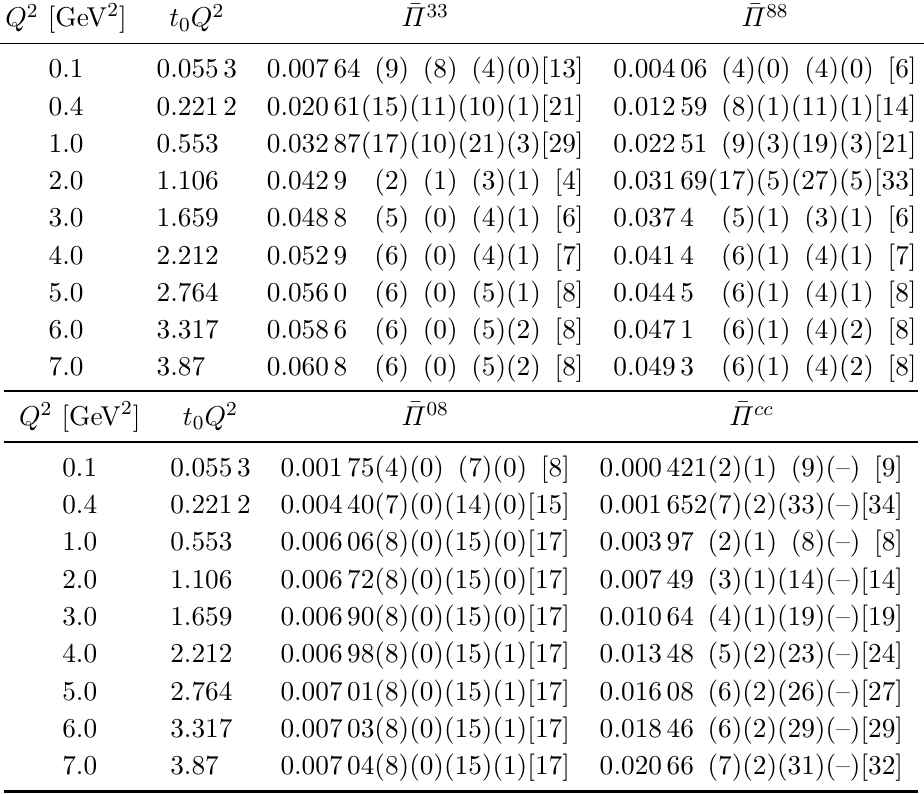
Table 5 . Contributions to the running extrapolated to the physical point. The first quoted uncertainty is the statistical error, the second is the systematic error from varying the fit model estimated in section 4.1.1, the third is the scale-setting error (see section 4.2.1), and the fourth is the systematic from missing charm sea-quark loops (see section 4.2.2). The final uncertainty, quoted in square brackets, is the combination of the previous ones.